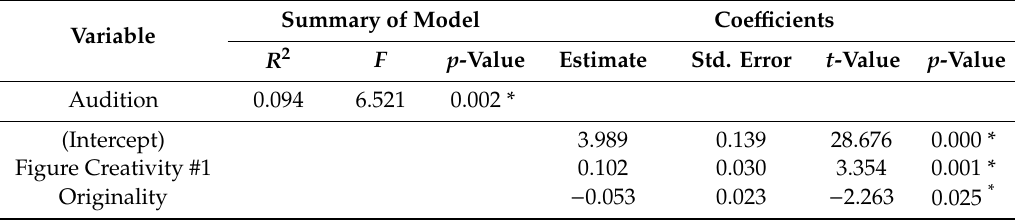
Figure Creativity